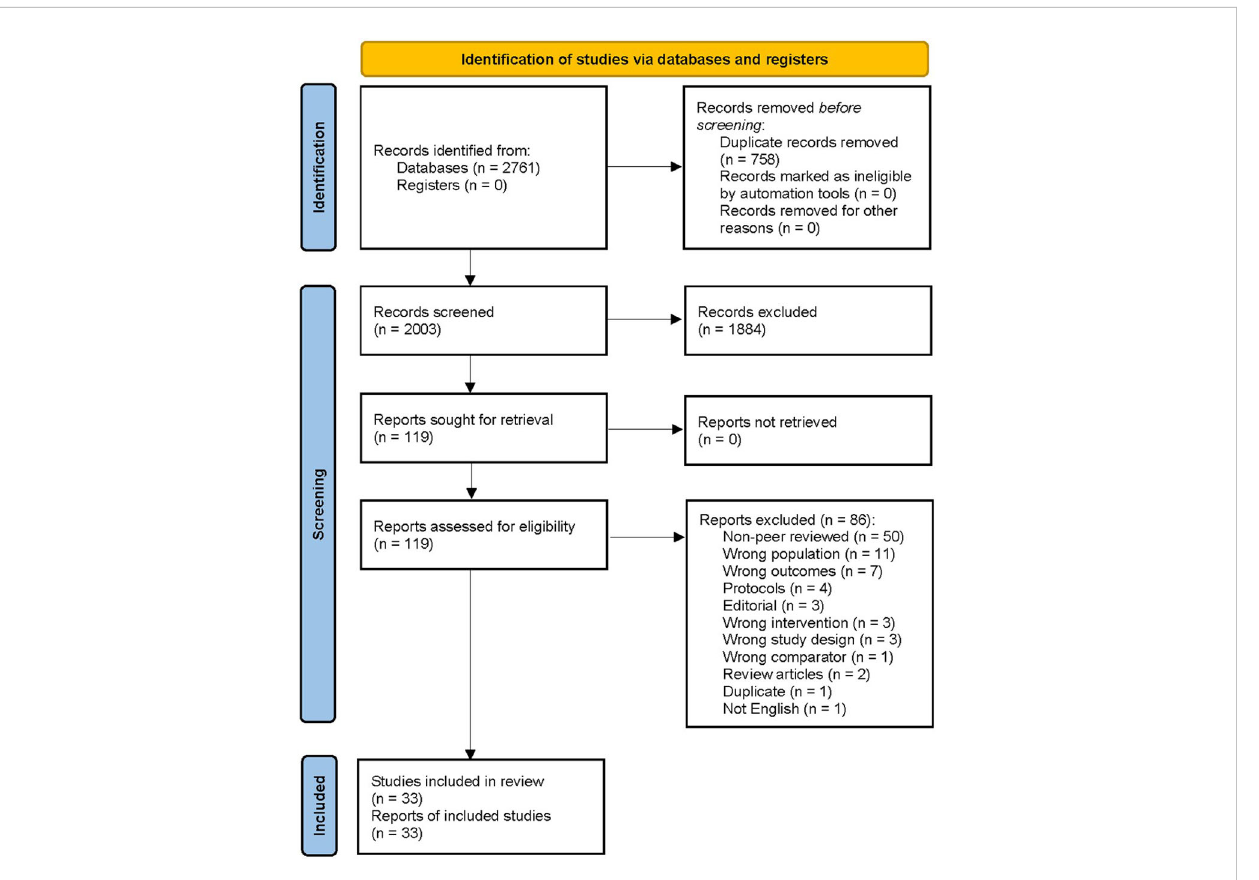
FIGURE 1 Flow diagram of the study selection in the systematic literature